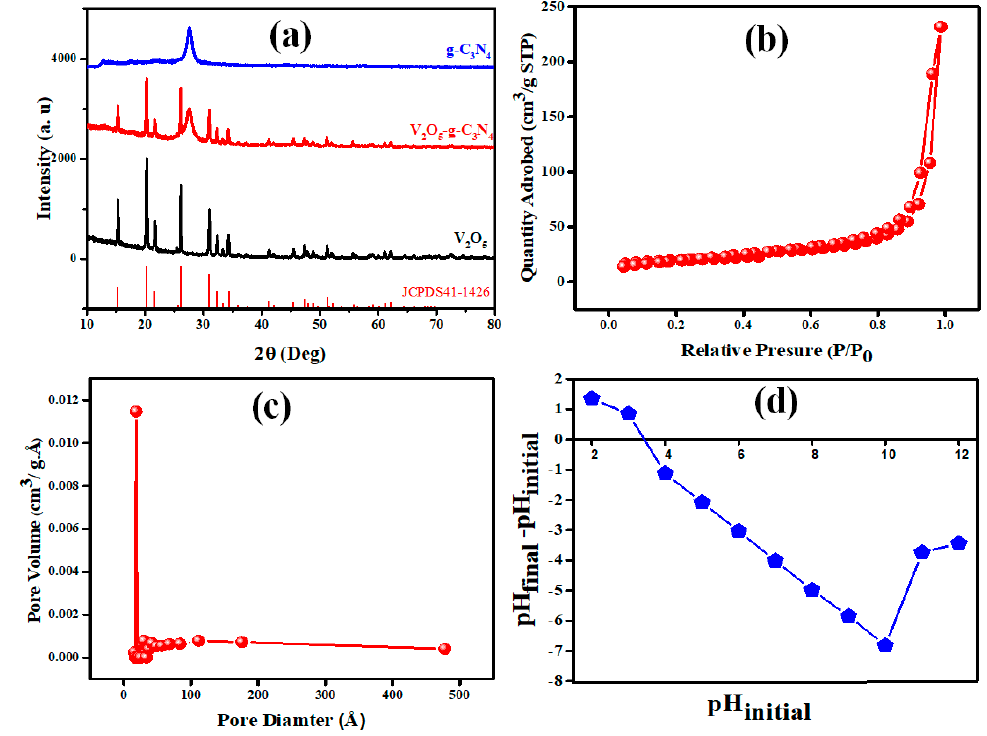
Figure 2. ( a ) XRD patterns of V 2 O 5 -g-C 3 N 4 , V 2 O 5 , and g-C 3 N 4 , ( b ) nitrogen adsorption–desorption isotherm, ( c ) pore size distribution, and ( d ) plot for the determination of pHZPC for the V 2 O 5 -g-C 3 N 4 nanosorbent.